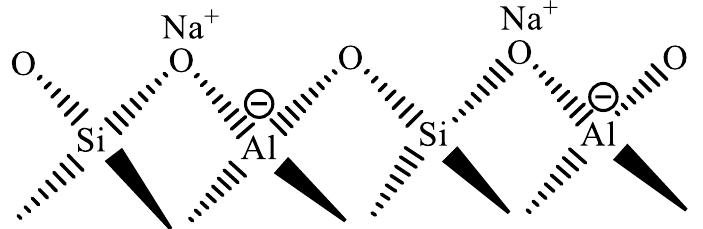
Figure 3. Schematic diagram of the structure of NaY zeolite.